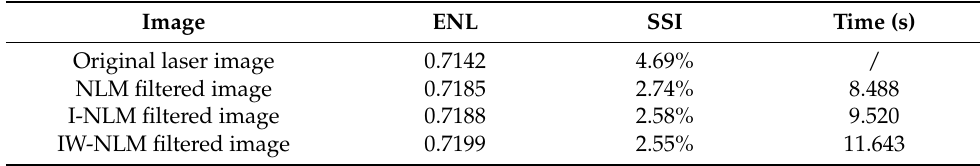
Table 2. Comparison of image quality evaluation indexes. Image ENL SSI Time (s) Original laser